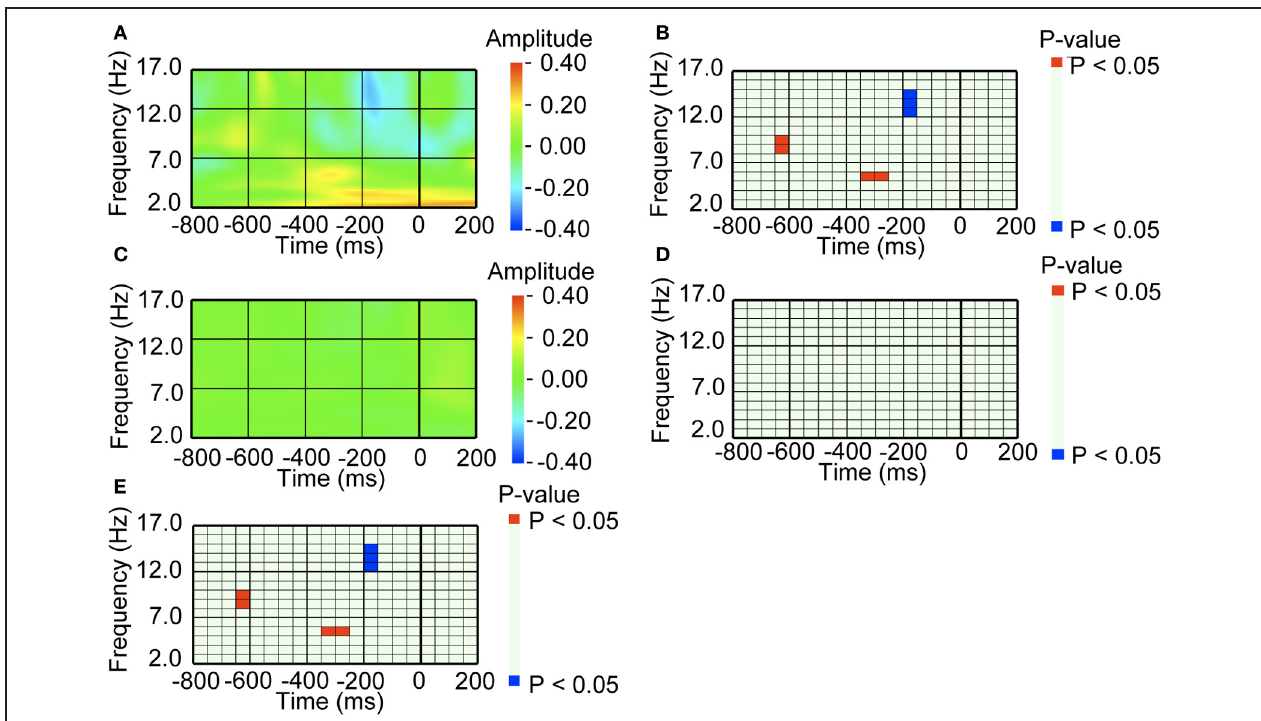
FIGURE A2 | EEG amplitude preceding a saccade, when a mother wavelet witha size of 3 cycles was used for the continuouswavelet transform. (A) Average waveform of the occipital recordings (O2) aligned with the pre-switch saccades that were followed by perceptual switching. The amplitude was Z-transformed, and the amplitude zero indicates baseline amplitude. (B) Statistical difference between average waveform aligned with the pre-switch saccades and baseline amplitude. The colors red and blue denote that amplitude was larger in the average waveform or baseline amplitude, respectively ( P < 0 . 05). (C) Average waveform of the occipital recordings (O2) aligned with the no-switch saccades. The